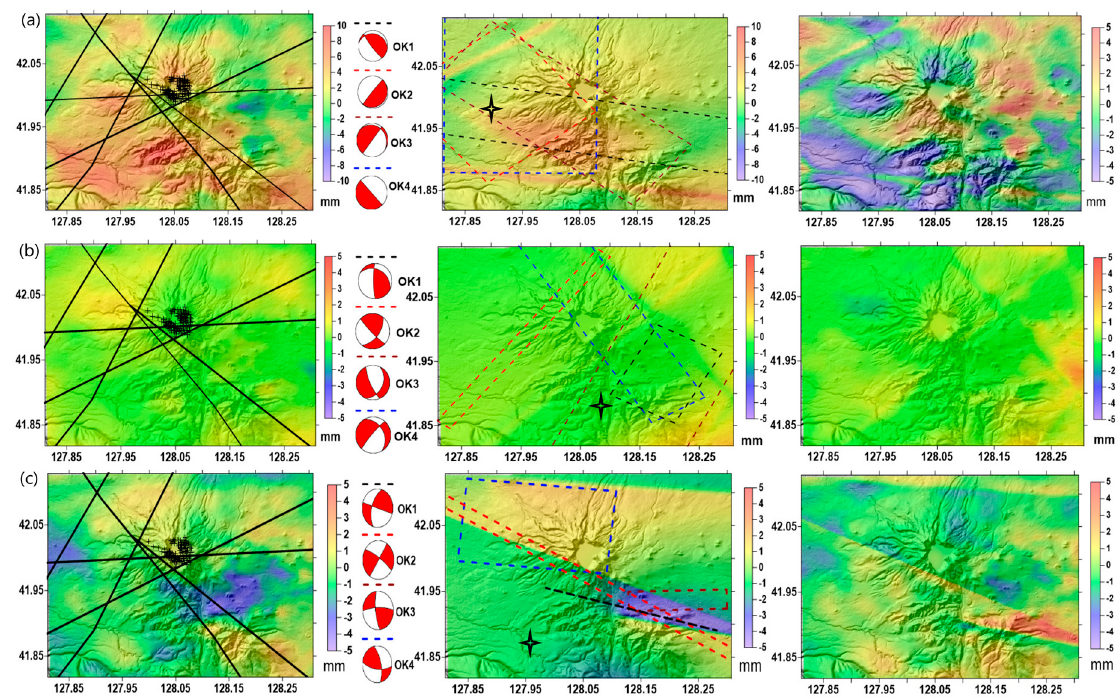
Figure 12. Deformation extracted by StaMPS/MTI observations (left column) and modelling with a Mogi, three Okada models (middle column) and error residuals (right column) for the time periods ( a ) 2007/08/31 – 2007/12/14, ( b ) 2008/03/28 – 2008/05/02, ( c ) 2010/02/26 – 2010/04/02. The lines in ( a ) represented the fault lines inferred from [5] and the crosses are the epicenters of earthquakes during 2002–2005 [2]. The dotted lines in ( b ) are projected outlines of Okada deformation sources (OK1 to OK4) and the star signs are for the location of Mogi type sources. Note rough discontinuities of deformation patterns in the location of the fault line by StaMPS/MTI observations.